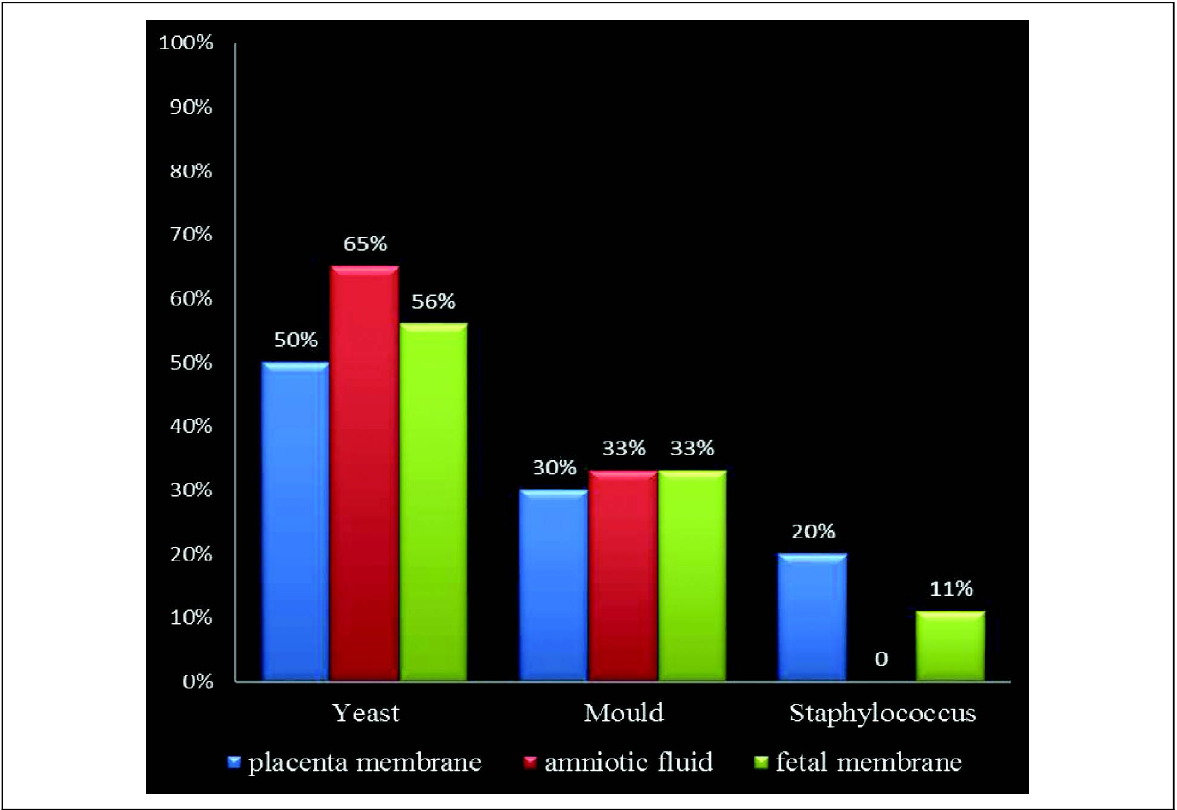
Figure 3: The most dominant microorganisms isolated from women with term